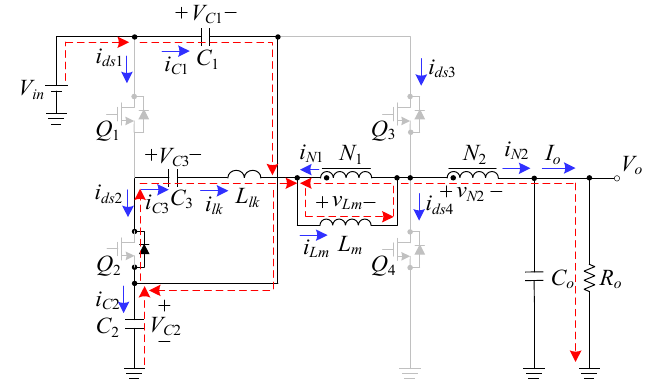
Figure 6. Current flow during state 3.